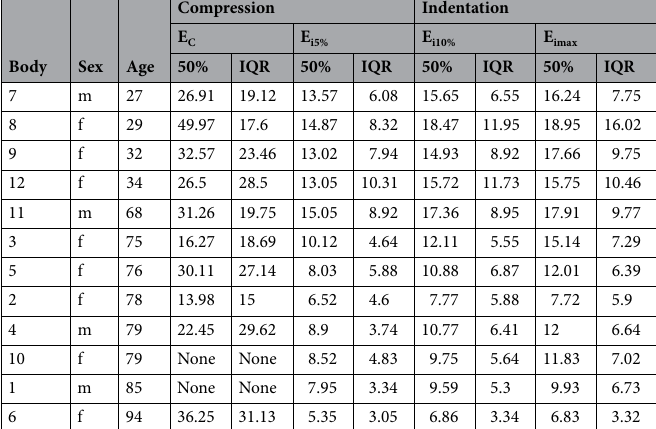
Table 2. Overview of all results per body, given as median and interquartile ranges (IQR). The table is ordered by the age of the body donors. E i5% , E i10% , E imax are the Young’s Moduli of indentation at a strain of 5%, 10% and at the maximum strain (Eimax). E C is the Young’s Modulus of